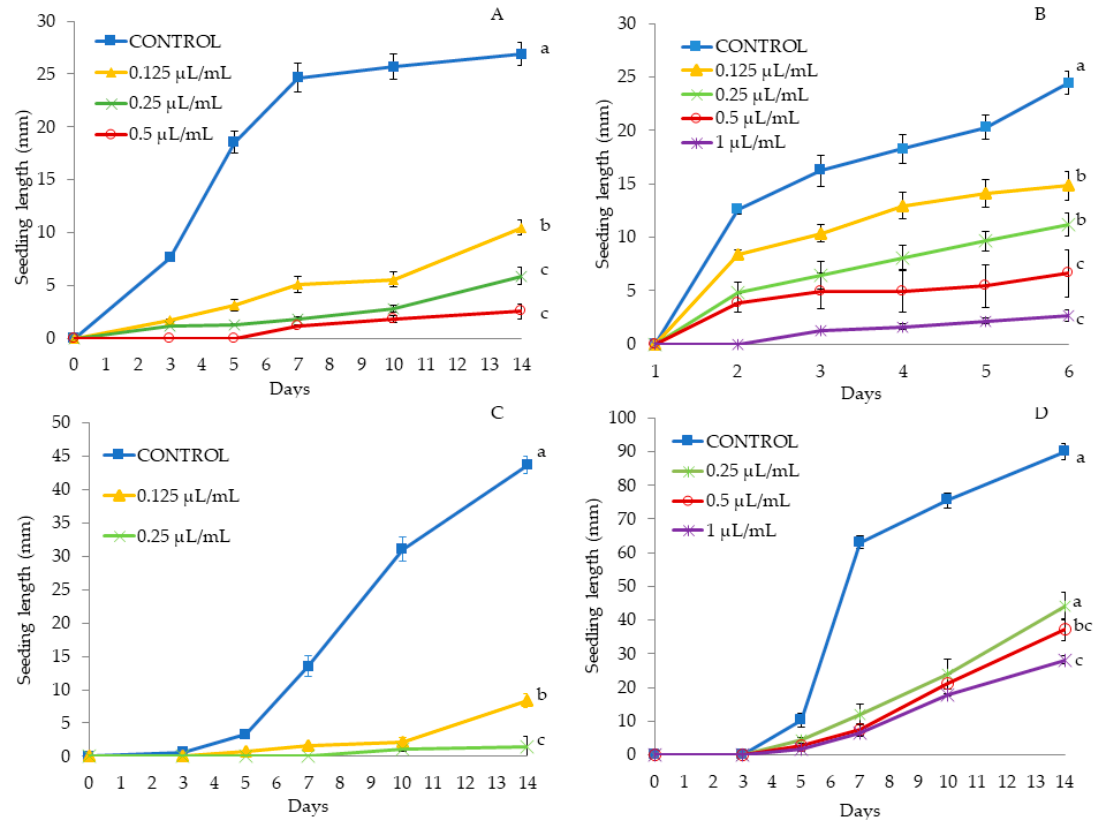
Figure 4. Phytotoxic effects of Thymbra capitata EO (TC4) on A. retroflexus ( A ), P. oleracea ( B ), A. fatua ( C ) and E. crus-galli ( D ) seedling length (mm) (mean ± SE), measured for 14 days. Different letters at the end of the growth curves indicate significant differences among doses ( p < 0.05) using Fisher’s least significant difference (LSD) test.